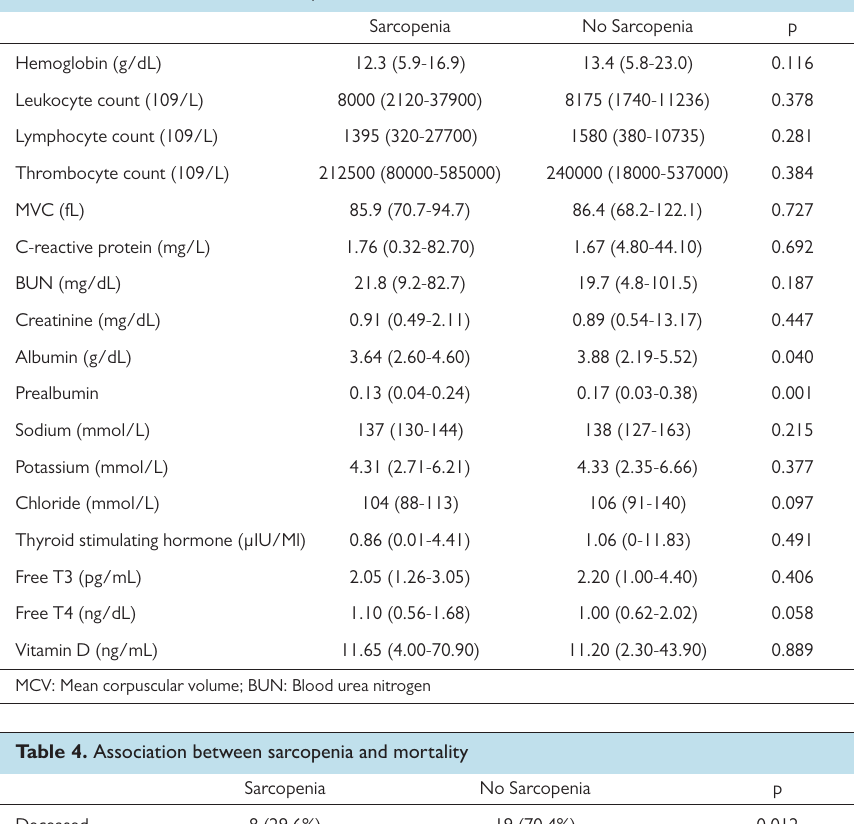
Table 3. Association between sarcopenia and